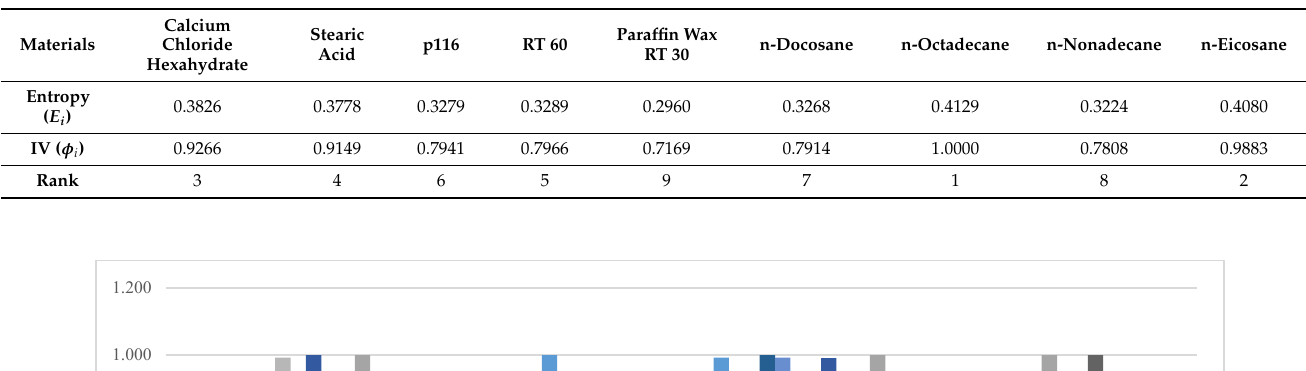
Table 3. The ranks of materials obtained by IVEP using the information value (IV).